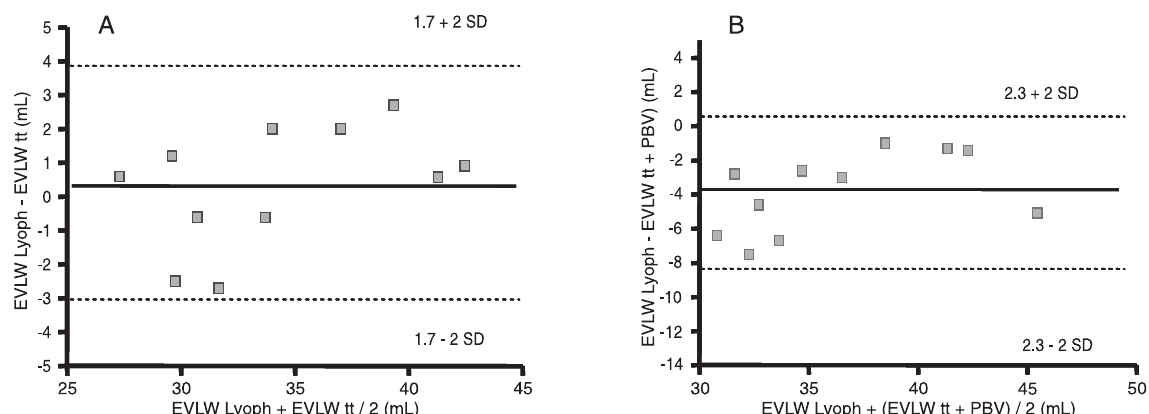
Figure 1. A , Bland-Altman analysis comparing EVLW measured by tt and LW determined by lyophylization (Lyoph). The abscissa shows the average of both measures and the ordinate shows the difference between ex vivo (LW) and in vivo (tt) assessment of lung water. Bias (LW - EVLW tt) was 0.3 mL (solid line); bias SD was 1.7 mL and the 95% confidence interval was -3.1 to +3.8 mL (dotted line). B , Bland-Altman analysis comparing EVLW tt + PBV and LW ex vivo . The abscissa shows the mean of the two types of measure - ments and the ordinate shows the difference between the two methods. Bias (lyophilized-thermodilution values) was -3.8 mL (solid line); bias SD was 2.3 mL and the 95% confidence interval was -8.4 mL to +0.69 mL (dotted line). EVLW = extravascular lung water; tt = transcardiopulmonary thermodilution; LW = lung water; PBV = pulmonary blood volume.